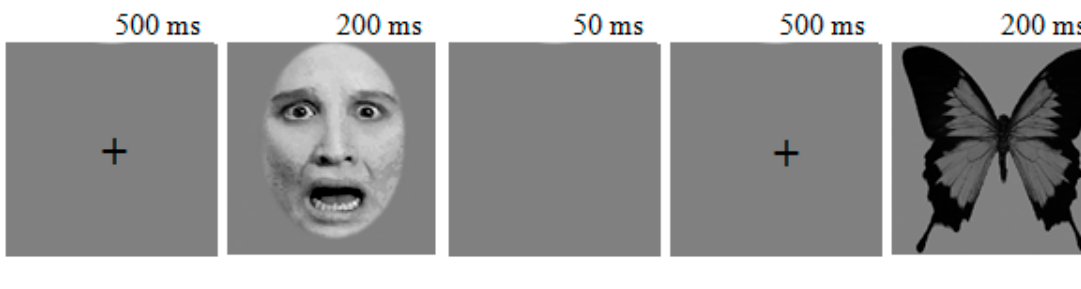
Figure 2. Example of the task.